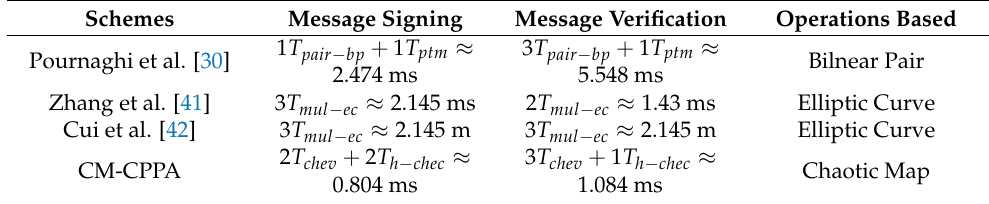
Table 2. Comparison of Computation